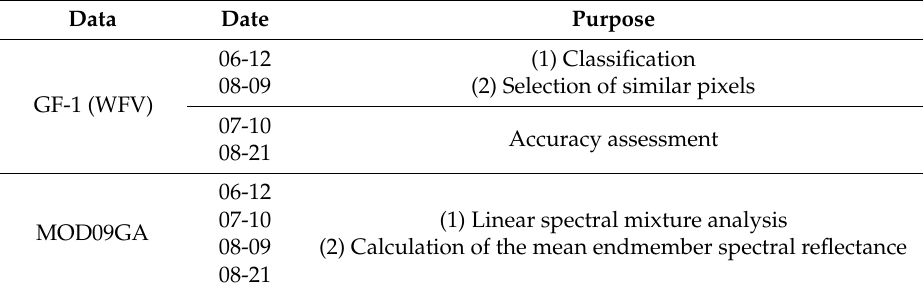
Table 2. Main Purpose of the GF-1 WFV and MODIS data used in the experiment.